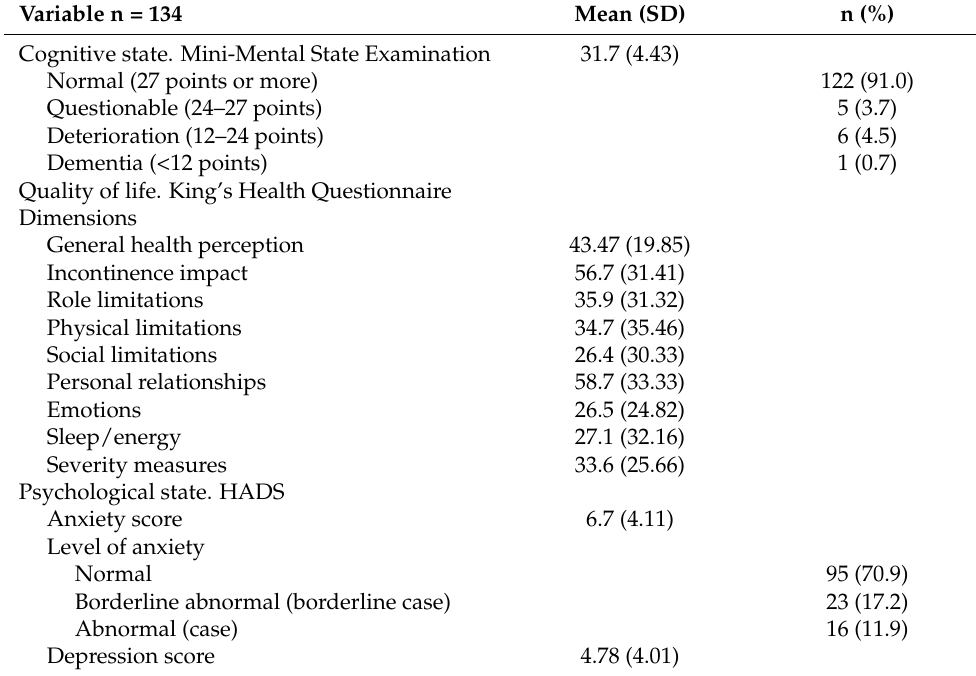
Table 5. Cognitive characteristics, quality of life, and psychological state of the study patients at the first visit (T0). HADS—Hospital Anxiety and Depression